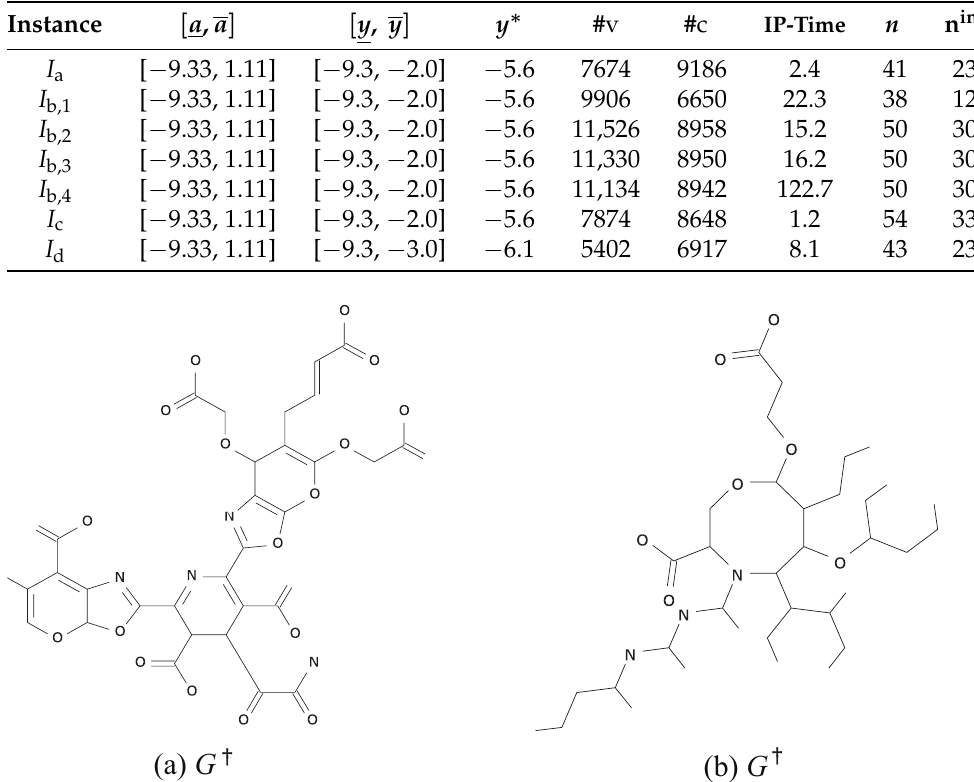
Figure 11. ( a ) G † inferred from I c with y ∗ = 3.0 of K OW ; ( b ) G † inferred from I d with y ∗ = 1.6 of L P